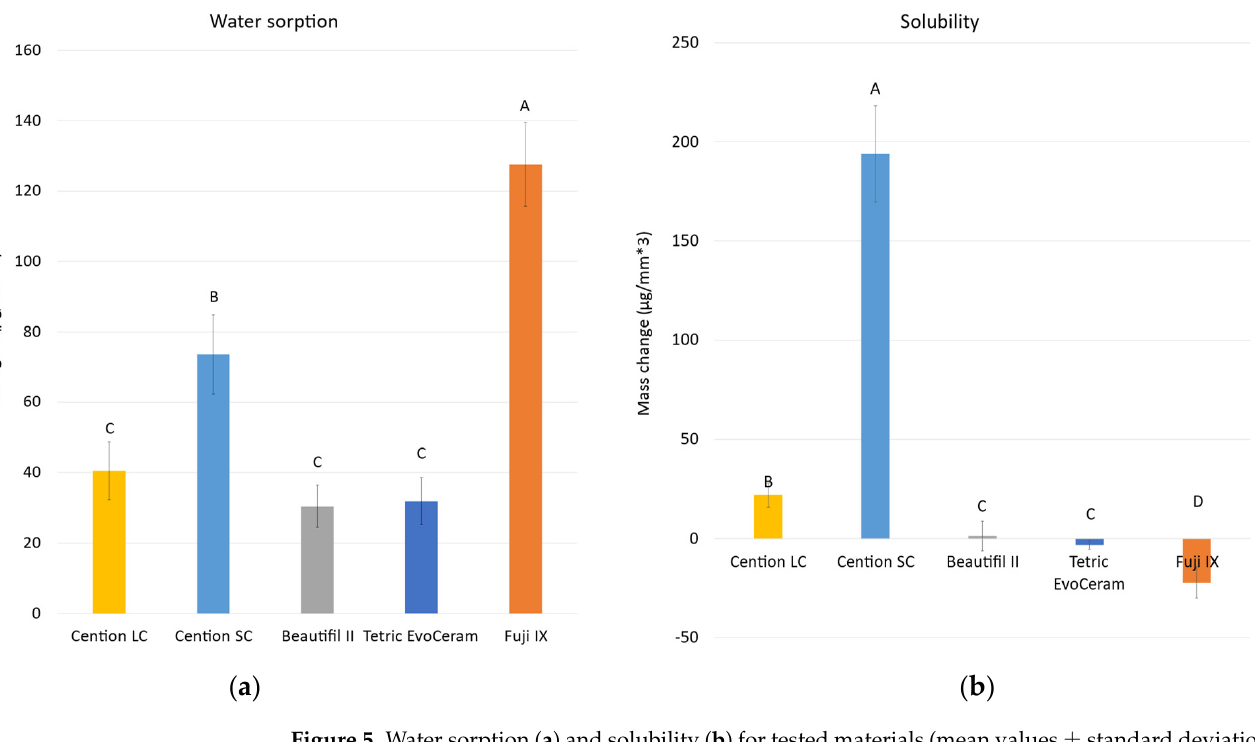
Figure 5. Water sorption ( a ) and solubility ( b ) for tested materials (mean values ± standard deviation, n = 10). Identical uppercase letters denote p > 0.05.